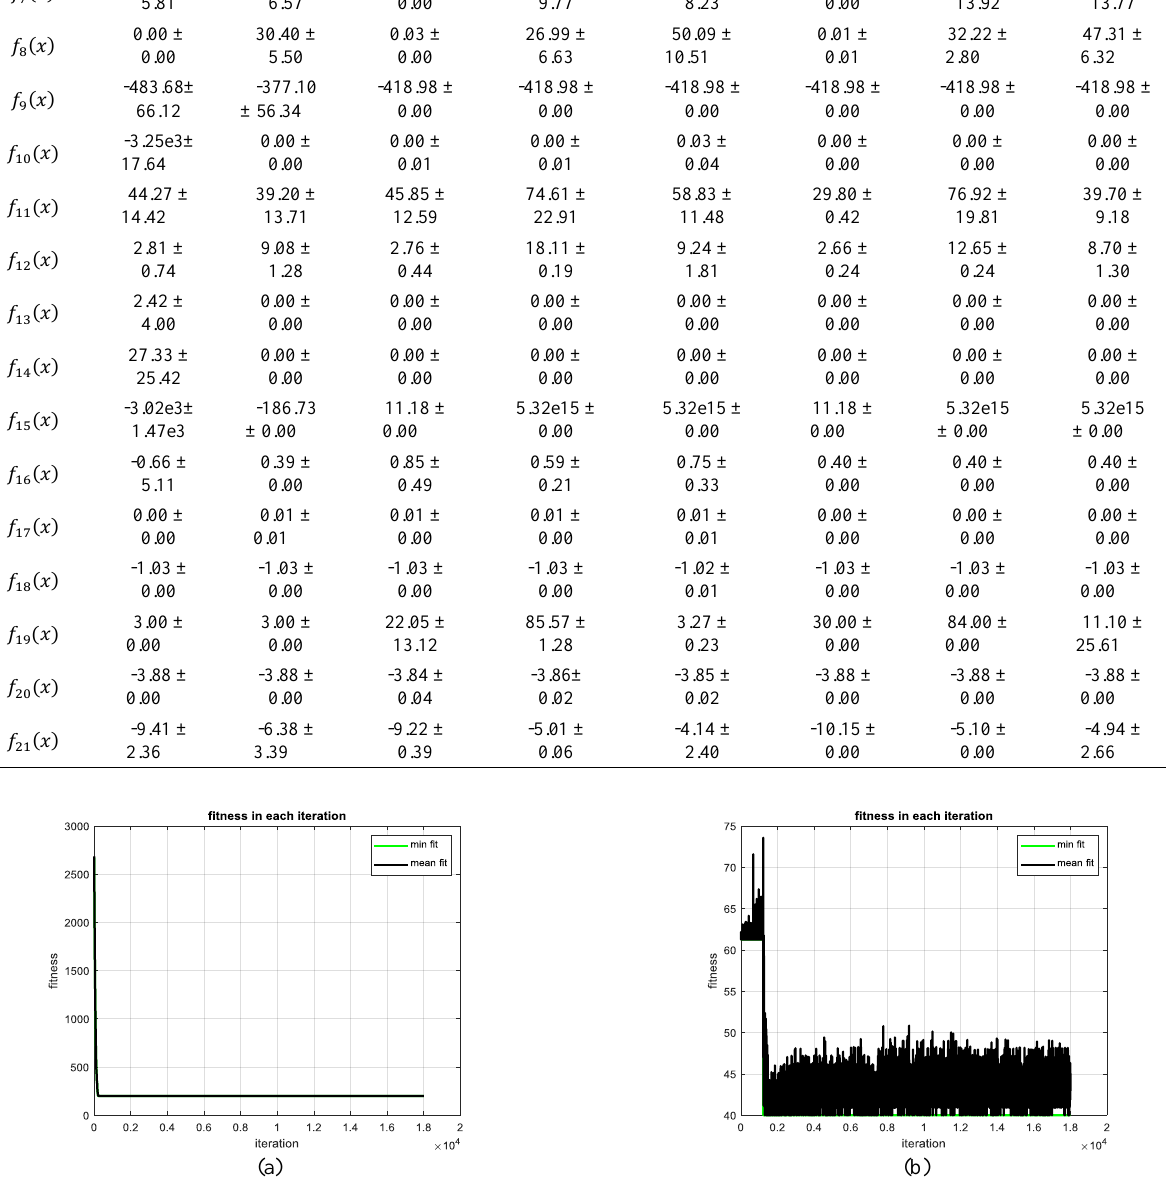
Figure 7. Convergence of the chaotic-based AIW-PSO with Tent map for two sample functions (a) f2 (b)